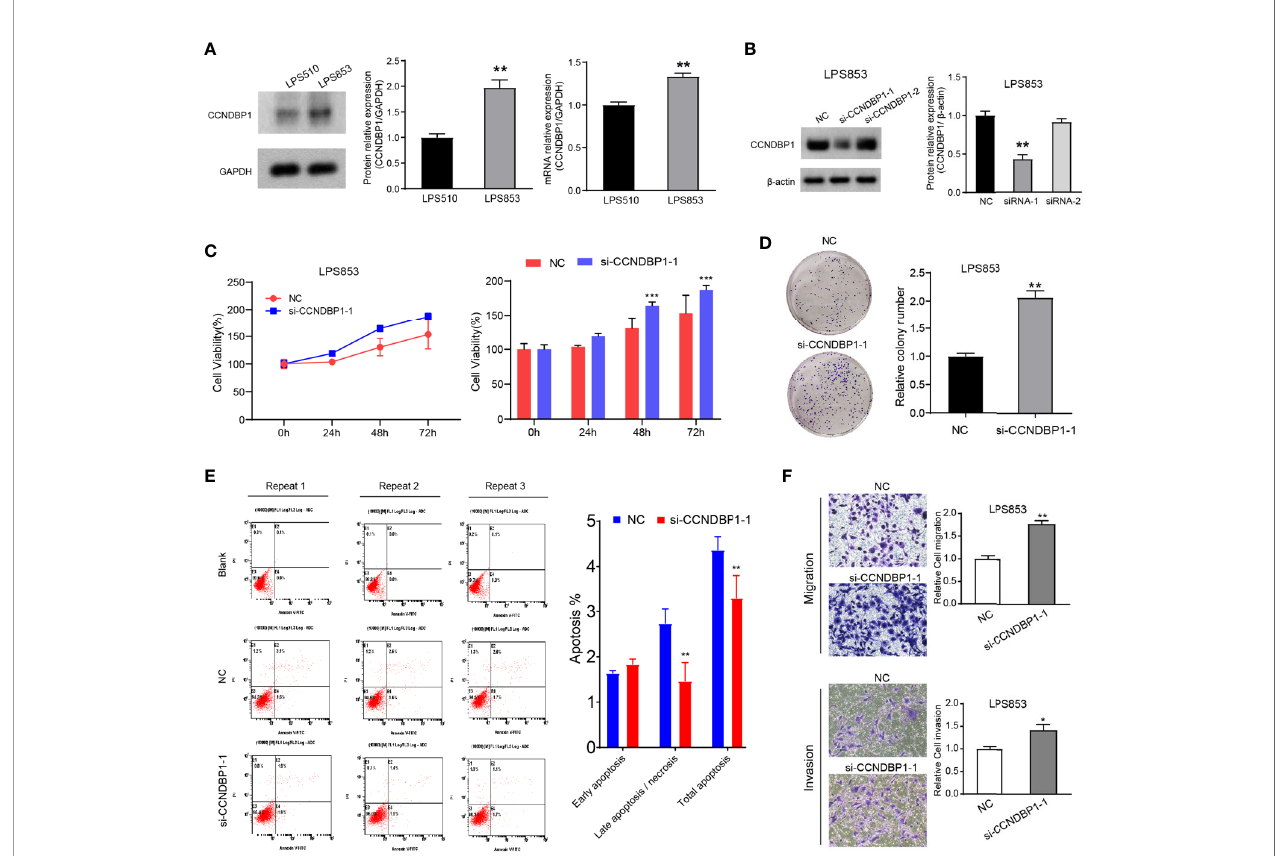
FIGURE 4 | Interfering with the expression of CCNDBP1 could signi fi cantly promote the clone formation, proliferation, migration, and invasion capacities of LPS853, and could decrease cell apoptosis. (A) LPS853 cells had a higher CCNDBP1 protein and mRNA expression level than LPS510; (B) Compared with the NC group, CCNDBP1 protein expression level declined after transfected CCNDBP1 siRNA1, and the difference had a statistical signi fi cance; (C) CCK8 experiment veri fi ed that the cell proliferation capacity was improved after the interference of CCNDBP1 expression in LPS853 and signi fi cant difference occurred from the 48 h; (D) Clone formation experiment veri fi ed that the clone formation capacity was improved after the interference of CCNDBP1 expression in LPS853; (E) The total apoptosis rate of LPS853 cells in the CCNDBP1-siRNA1 group was increased to a certain extent in comparison with the NC group, and the difference between the two groups had a statistical signi fi cance, mainly because of decrease in late apoptosis and necrosis cells; (F) The migration and invasion capacities of LPS853 in the siRNA group were improved in comparison with the NC group; *P < 0.05; **P < 0.01; ***P <